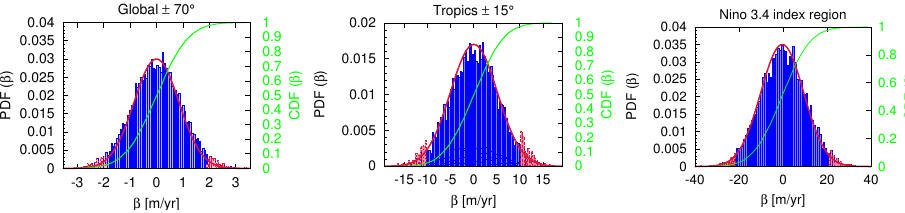
Figure 5. Normalized bootstrap (resamples n =10 4 ) distributions of trend β for global (left), tropical (middle) regions and central East Figure6.6: Normalizedbootstrap(resamples n = 10000)distributionsoftrend β for(a)globaland(b)tropical regions. Theredtailsindicatetheconfidenceinterval(CI)at95%(2 σ β ). GloballyCI =[ -1.913,1.912 ] m / year, Pacific (right, 170–120 ◦ W, 5 ◦ N–5 ◦ S). The red tails indicate the confidence interval (CI) at 95%. A Gaussian distribution and a cumulative · whileinthetropicsCI =[ -10.4,10.1 ] m / year. distribution function are plotted in red and green, Figure6.6: Normalizedbootstrap(resamples n = 10000)distributionsoftrend β for(a)globaland(b)tropical Fig. 5. Normalised bootstrap (resamples n =10 4 ) distributions of trend β for global (left), tropical (mid) regions regions. Theredtailsindicatetheconfidenceinterval(CI)at95%(2 σ β ). GloballyCI =[ -1.913,1.912 ] m / year, cycle of Eq. (6.2) must be removed from the timeserie). In addition, the large-scale climate event ENSO · whileinthetropicsCI =[ -10.4,10.1 ] m / year. is removed (as discussed in Section 6.3.2), by masking the corresponding pacific regions, because of and Central East Pacific (170 ◦ W-120 ◦ W, 5 ◦ N-5 ◦ S). The red tails indicate the confidence interval (CI) at 95%. its intra-annual component and the trend magnitude β of cloud top height anomalies is calculated, at A Gaussian distribution and a cumulative distribution function are plotted in red and green, respectively. latitude and longitude ( i , j ) , with cycle of Eq. (6.2) must be removed from the timeserie). In addition, the large-scale climate event ENSO is removed (as discussed in Section 6.3.2), by masking the corresponding pacific regions, because of